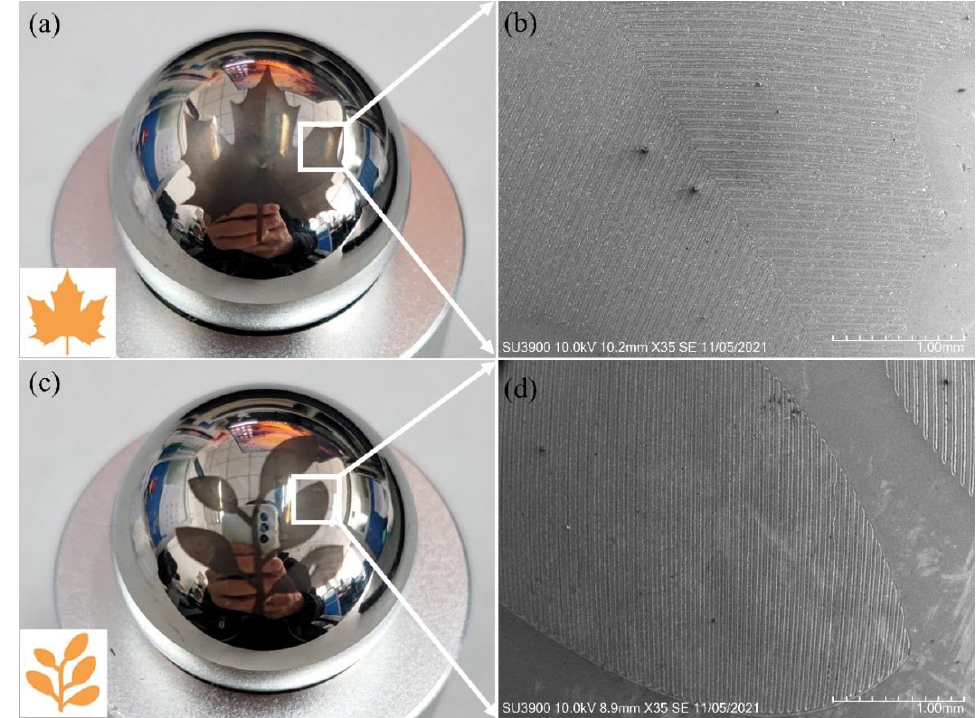
Figure 12. Patterns of ( a ) maple leaf and ( c ) saplings fabricated on stainless steel sphere. SEM image of local area composed of groove arrays in the fabricated ( b ) maple leaf and ( d ) saplings.